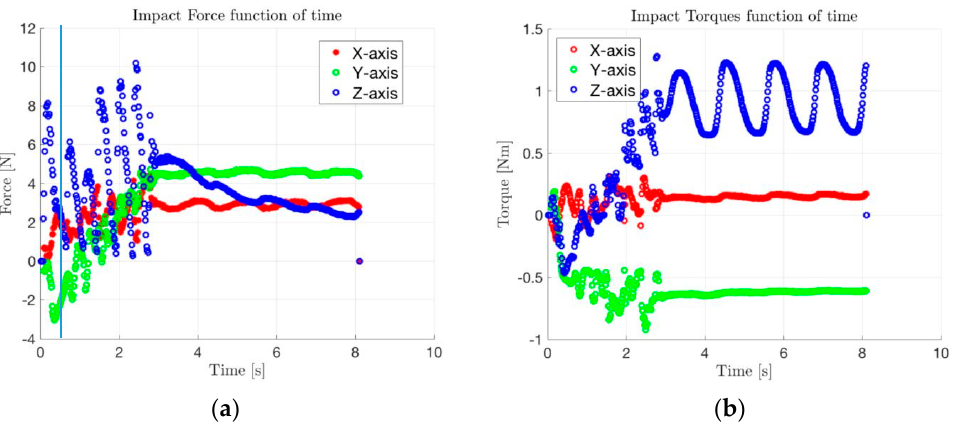
Figure 10. Nominal Case ( v = 0.030 m/s; α = 2 deg): ( a ) forces at impact and ( b ) torques at impact.